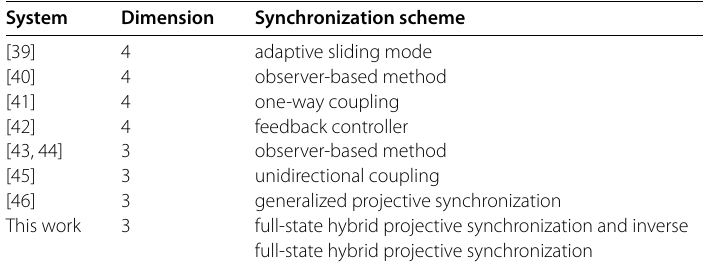
Table 1 Synchronization schemes used for fractional-order forms of chaotic systems with hidden